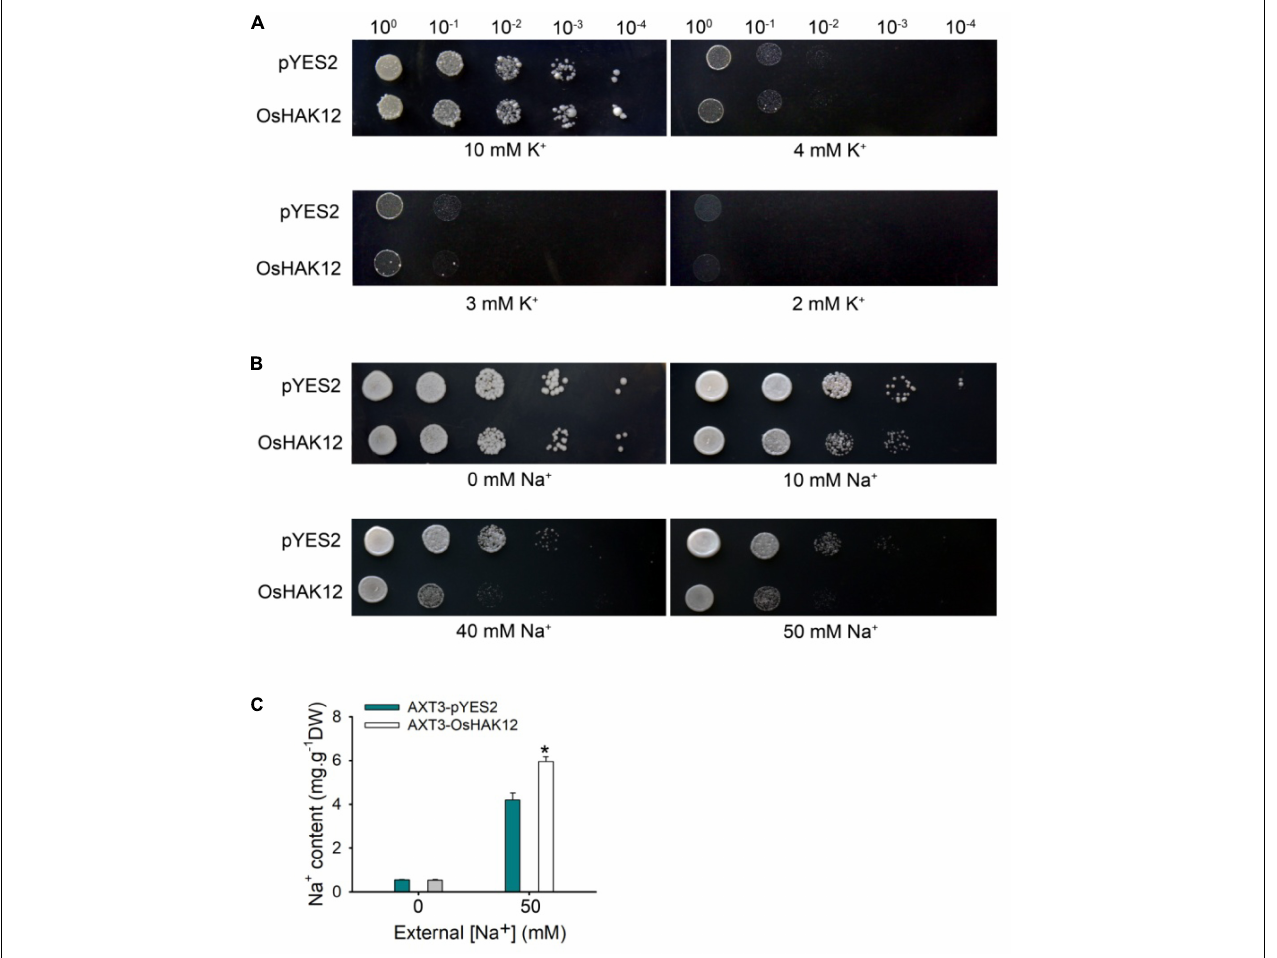
FIGURE 6 | Functional complementation analysis of OsHAK12 in yeast mutants. (A) The empty vector pYES2 and pYES2 -OsHAK12 were separately introduced into the K + uptake deficient yeast strain CY162. The overnight cultures were harvested and the optical density at 600 nm were adjusted to 1.0, then cultured on the AP medium containing 2, 3, 4, or 10 mM K + at 30 ◦ C for 4 days. No significant differences were found between pYES2 and OsHAK12 when grown on the AP medium containing different K + concentrations. (B) The empty vector pYES2 and pYES2 -OsHAK12 were separately introduced into the Na + sensitive yeast strain AXT3K. The overnight cultures were harvested and the optical density at 600 nm were adjusted to 1.0, then cultured on the AP medium containing 0, 10, 40, or 50 mM Na + at 30 ◦ C for 4 days. Significant differences were found between pYES2 and OsHAK12 when grown on the AP medium above 10 mM Na + . (C) Na + concentration in AXT3K cells expressing the empty vector pYES2 and pYES2-OsHAK12. The Na + concentration in AXT3K cells expressing the empty vector pYES2 and pYES2 -OsHAK12 showed significant differences (* P < 0.01 by Student’s t -test). The experiment was repeated five times with similar results. Data are means of three replicates of one experiment. Asterisks represent significant differences. Error bars represent ± SD.